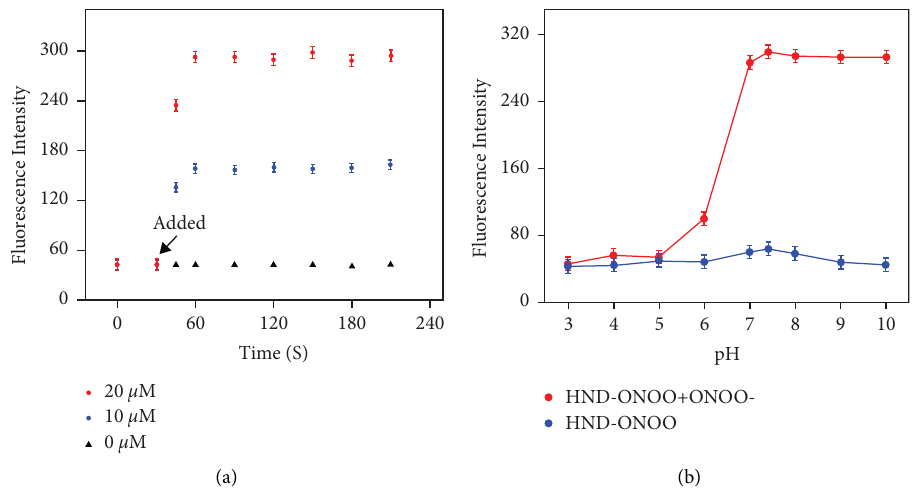
Figure 2: (a) Te response speed and (b) pH efect of HND-ONOO to ONOO − .